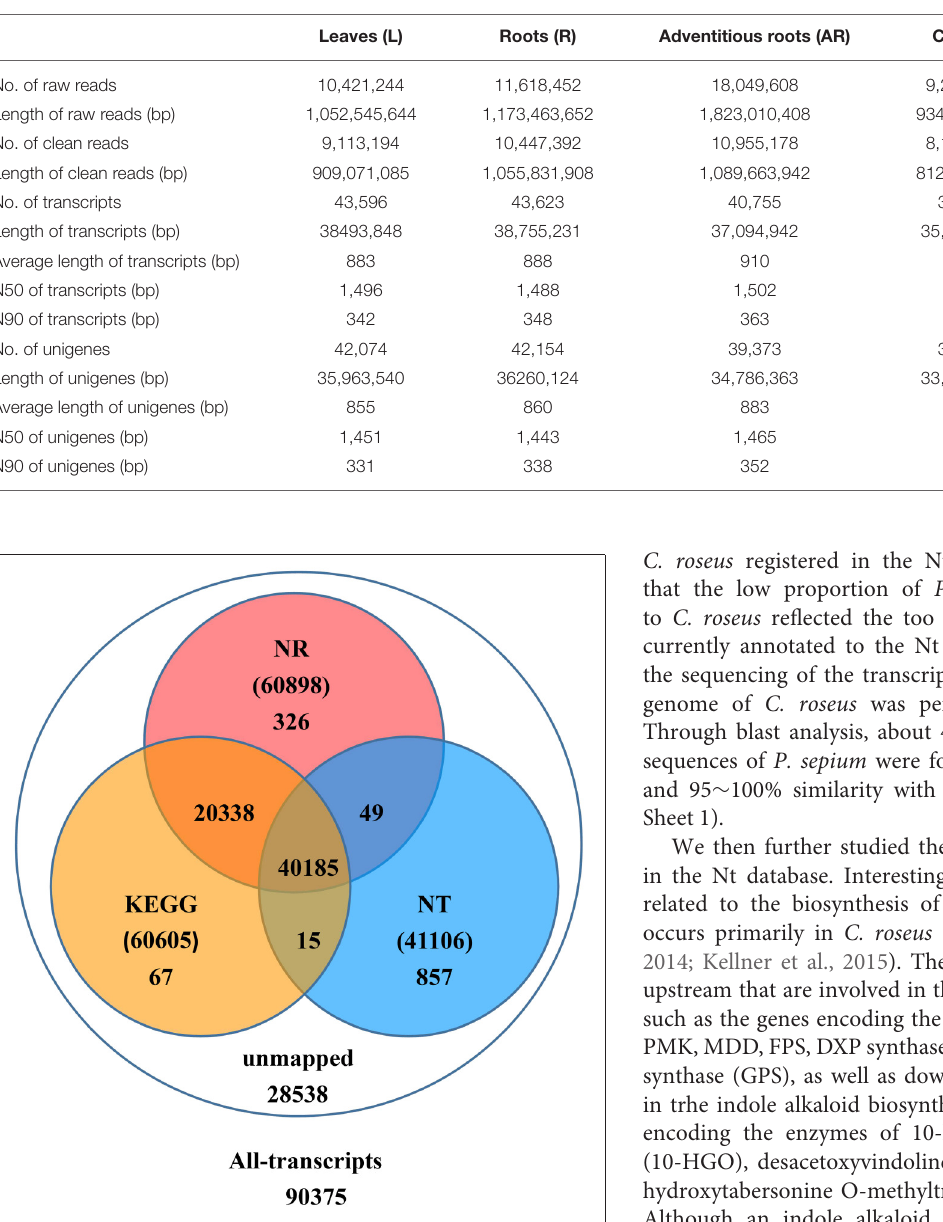
FIGURE 2 | Number of transcripts blasted to NR, NT, and KEGG ( E <